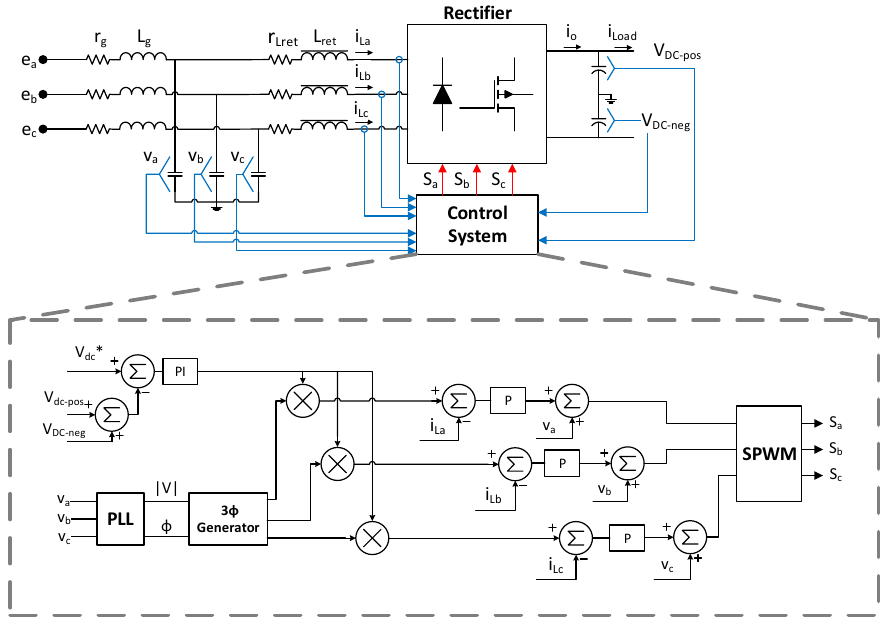
Figure 7. Control strategy applied for the